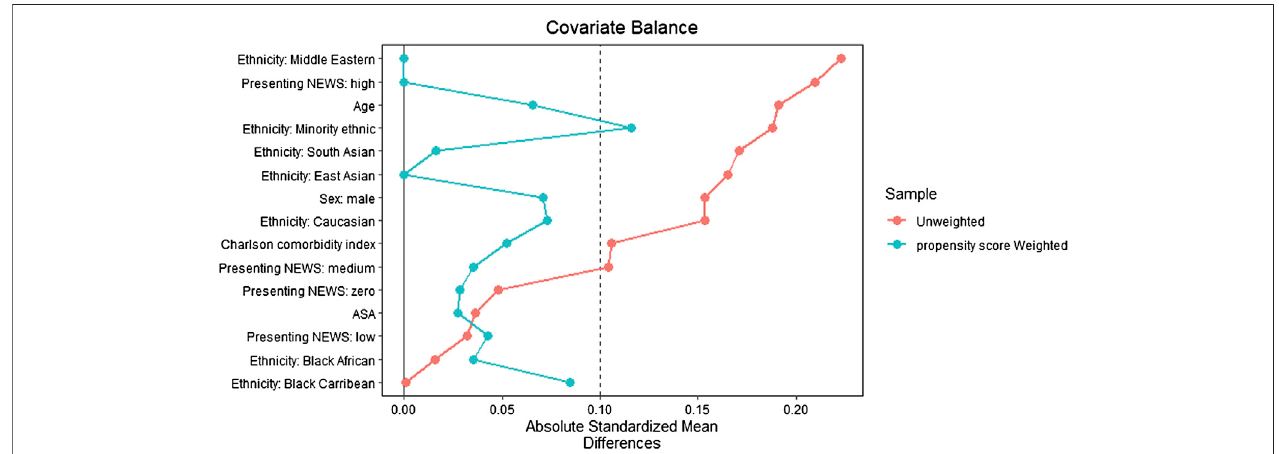
FIGURE 2 | Love plot depicting covariate balance with standardized mean differences following propensity score matching.